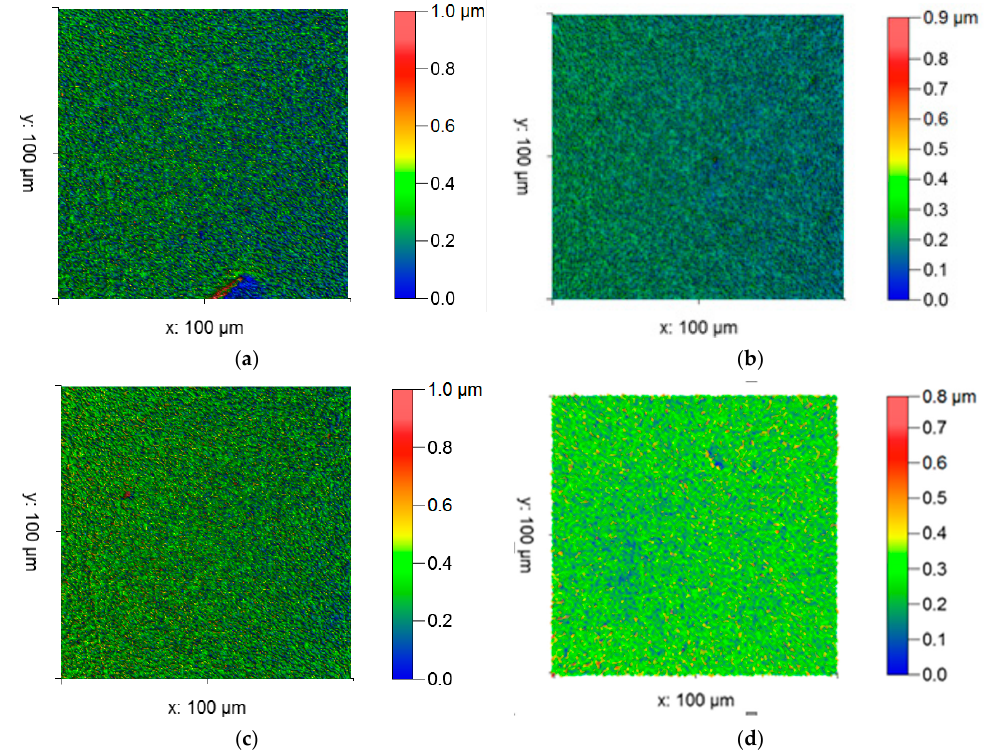
Figure 10. 2D laser profilometry of the corrosion test. ( a ) Expt. 1, ( b ) Expt. 2, ( c ) Expt. 3, and ( d ) Expt. 4.